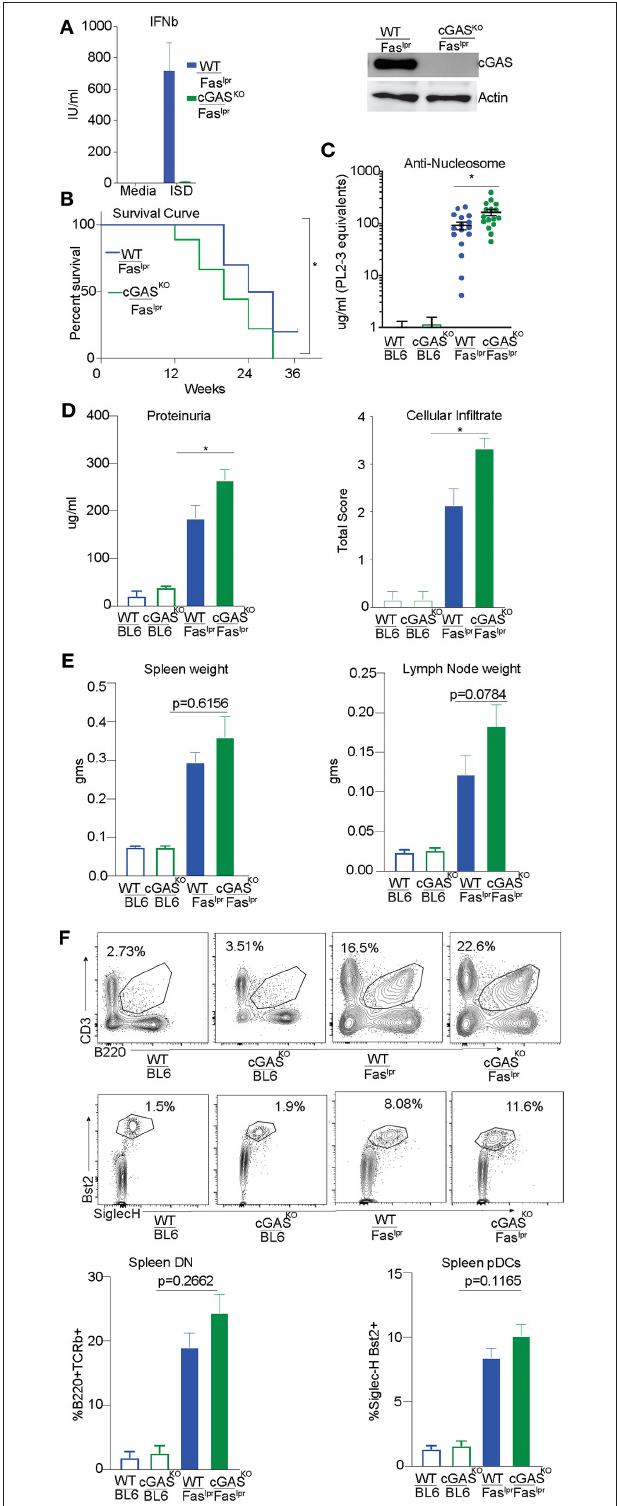
FIGURE 4 | cGAS deficiency does not rescue SLE-prone MRL/Fas lpr mice. (A) BMDMs were isolated from WT/ Fas lpr and cGAS KO / Fas lpr mice.